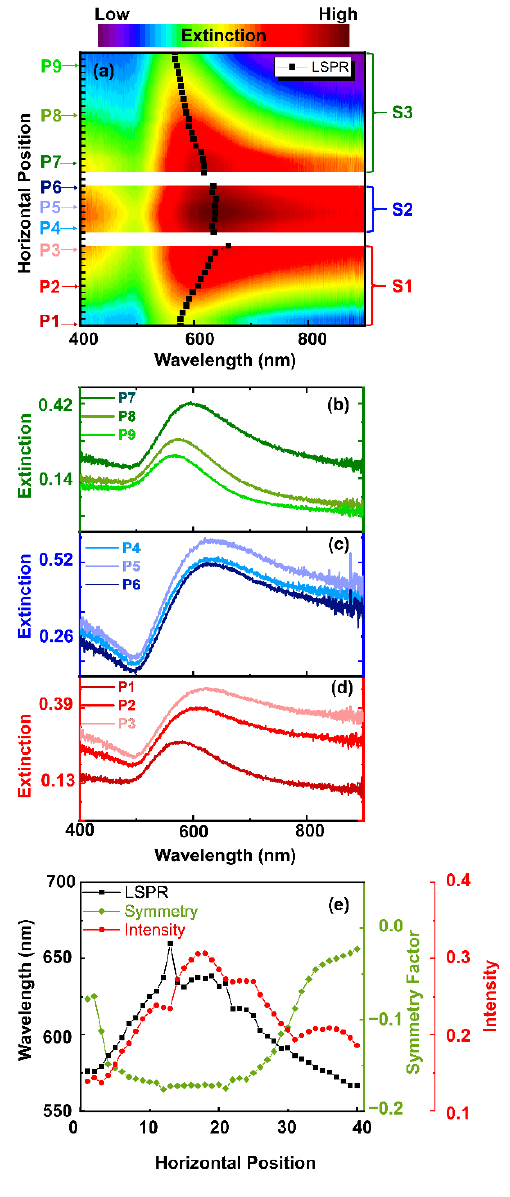
Figure 2. ( a ) Contour of the extinction spectra acquired across substrates S1, S2, and S3, as denoted schematically in orange at 40 locations in Figure 1a. The black markers illustrate the maximum of each spectrum. ( b ) Corresponding extinction spectra of S3 at points P7, P8, and P9, ( c ) corresponding extinction spectra of S2 at positions P4, P5, and P6, ( d ) corresponding extinction spectra of S1 at positions P1, P2, and P3, and ( e ) LSPR, amplitude and symmetry factor of extinction spectra in ( a ). In general, the extinction maximum of the spectra (illustrated by the black markers in Figure 2a) acquired across the three substrates shifts to longer wavelengths from S1 to